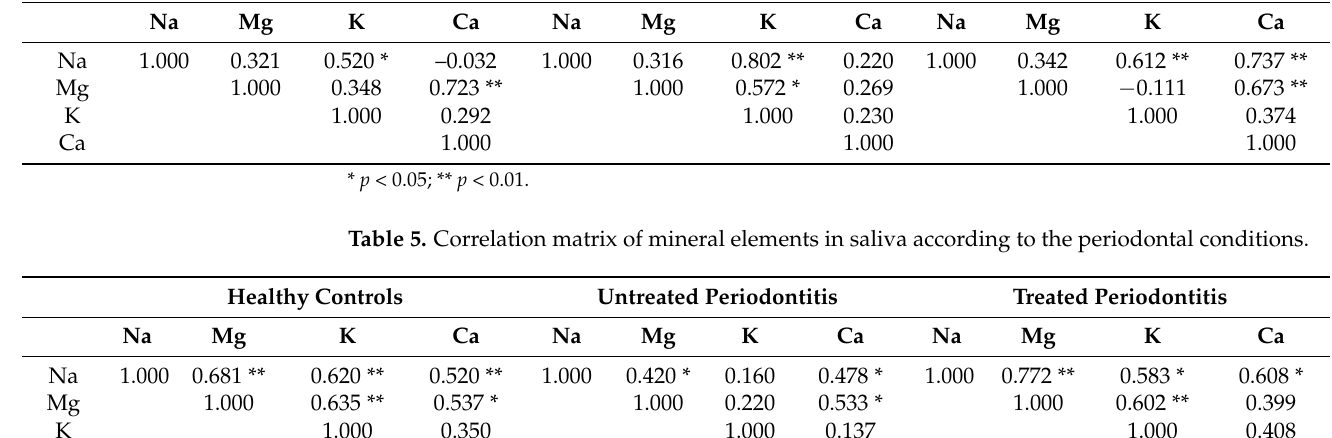
Table 4. Correlation matrix of mineral elements in GCF according to the periodontal conditions. Healthy Controls Untreated Periodontitis Treated Periodontitis